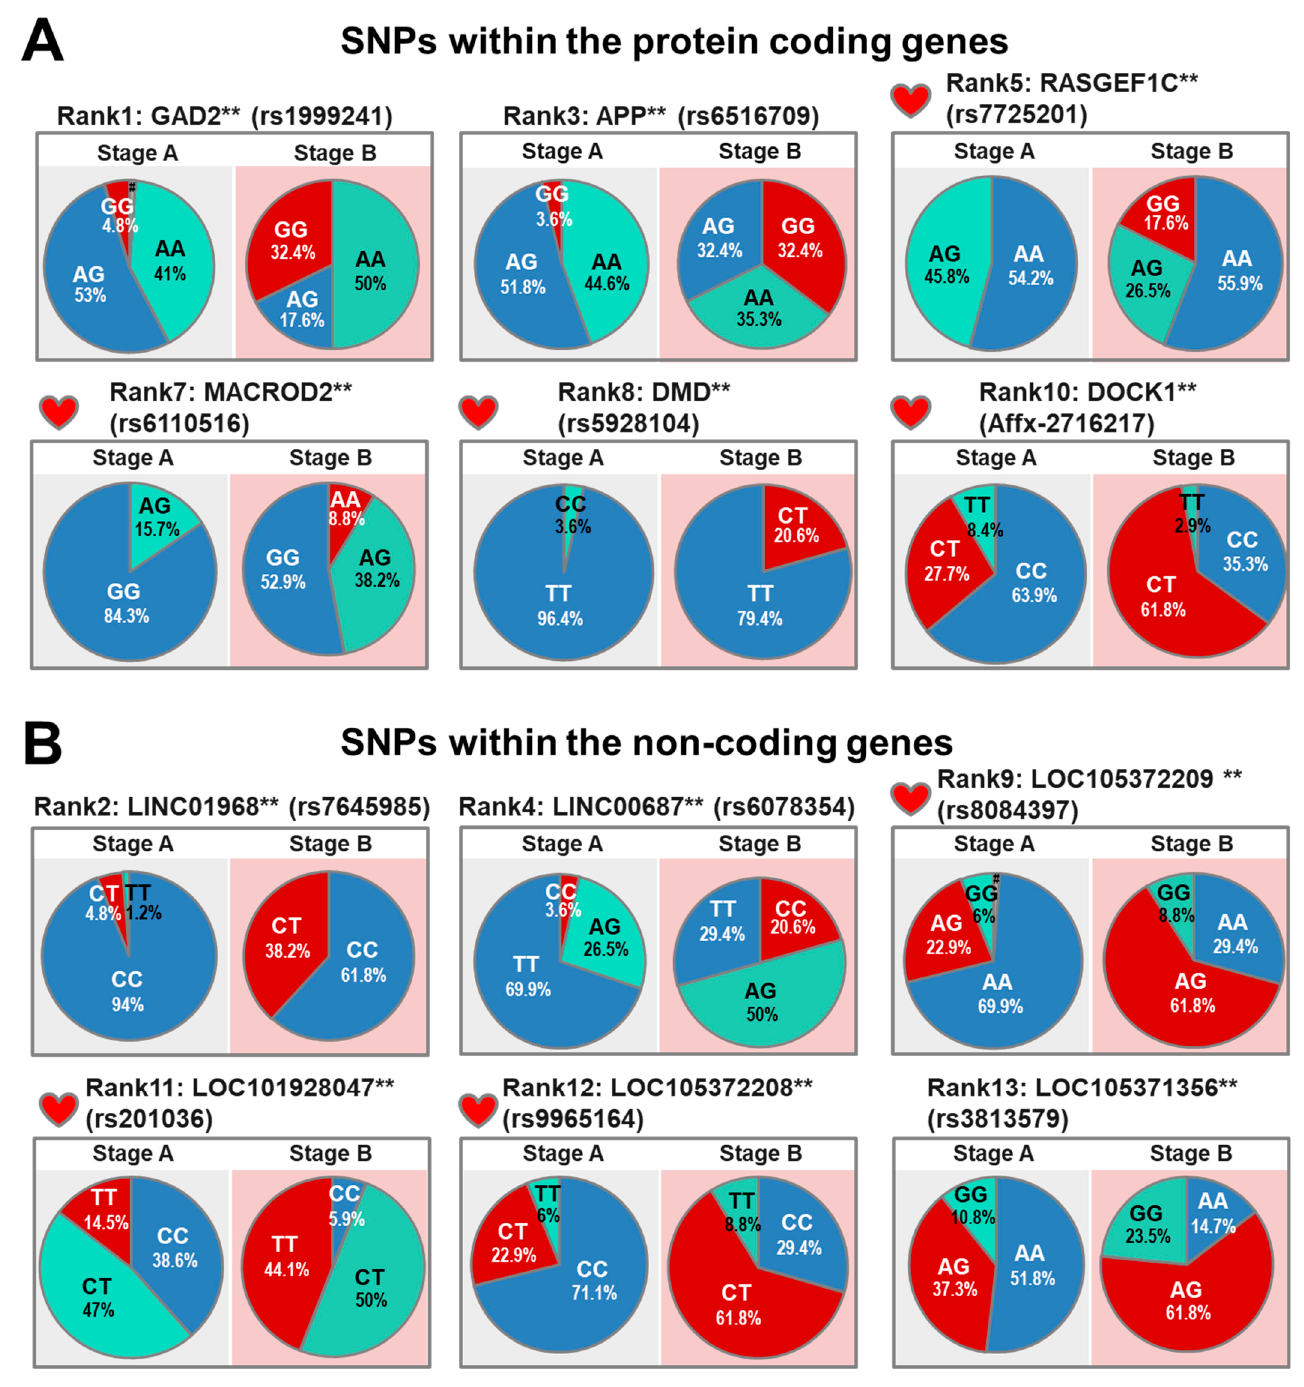
Figure 3. Pie charts indicating the genotype frequencies of the SNPs identified by AI-assisted analysis using the SNP datasets obtained from Stage A and B subjects. ( A ) Pie charts representing the AI-assisted SNPs within the protein-coding genes, excluding the pseudogene (PGAM1P5). Abbreviations include GAD2: glutamate decarboxylase 2; APP: amyloid beta precursor protein; RASGEF1C: RasGEF domain family member 1C; MACROD2: mono-ADP ribosylhydrolase 2; DMD: dystrophin; and DOCK1: dedicator of cytokinesis 1. ( B ) Pie charts representing the AI-assisted SNPs within the non- coding genes. rs8084397 is the SNP of LOC105372209 and LOC105372210, and rs201036 is the SNP of LOC101928047 and LOC101928004. # indicates that the signaling by the SNP array was lower than the calling rate. ** p < 0.005 by Chi-square test. When the non-coding RNA (ncRNA) genes were examined, two SNPs were intron variants of long intergenic ncRNA genes (LINC01968 and LINC00687), while the